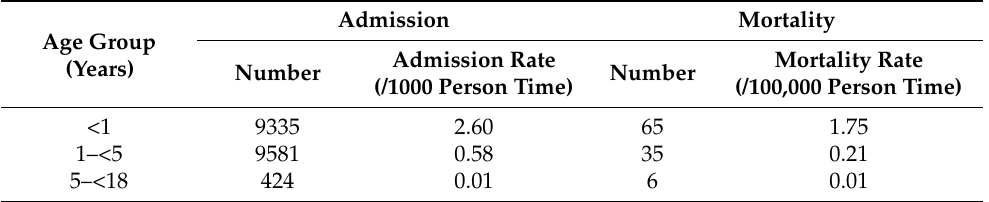
Table 2. Admission and mortality rates of RSV LRTI by age group in fiscal years 2015–2020.